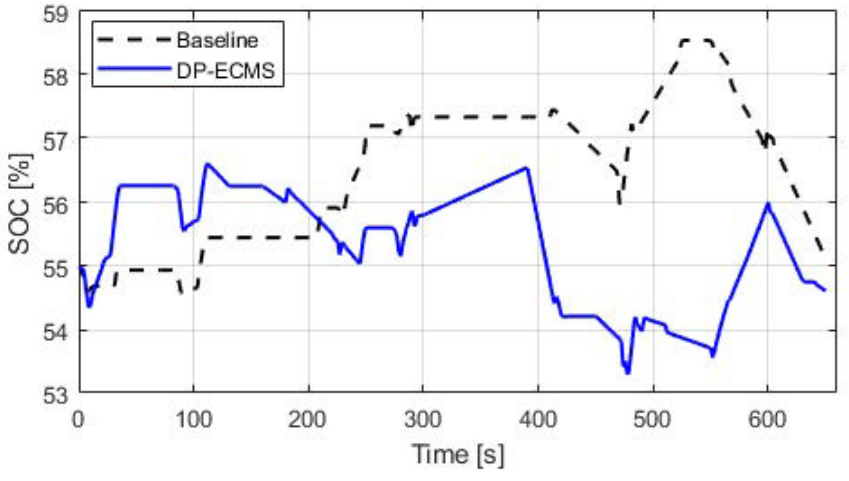
Figure 11. SOC comparison for DP-ECMS and